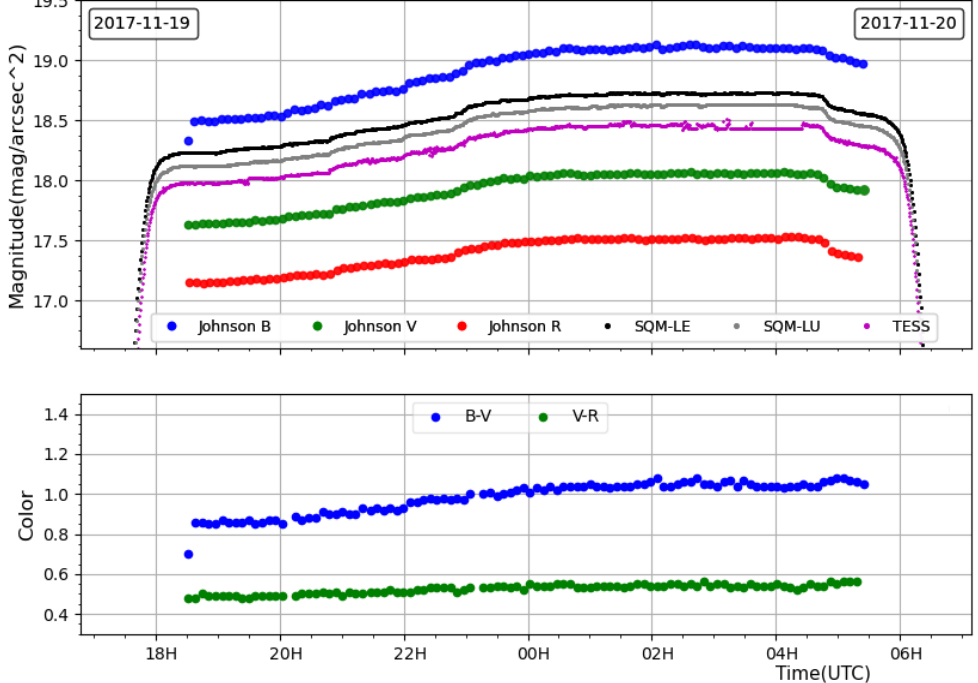
Figure 6. Brightness and color evolution of the sky during a photometric night in Madrid. While the brightness decreases monotonically during the first part of the night, the curve is almost flat after midnight.